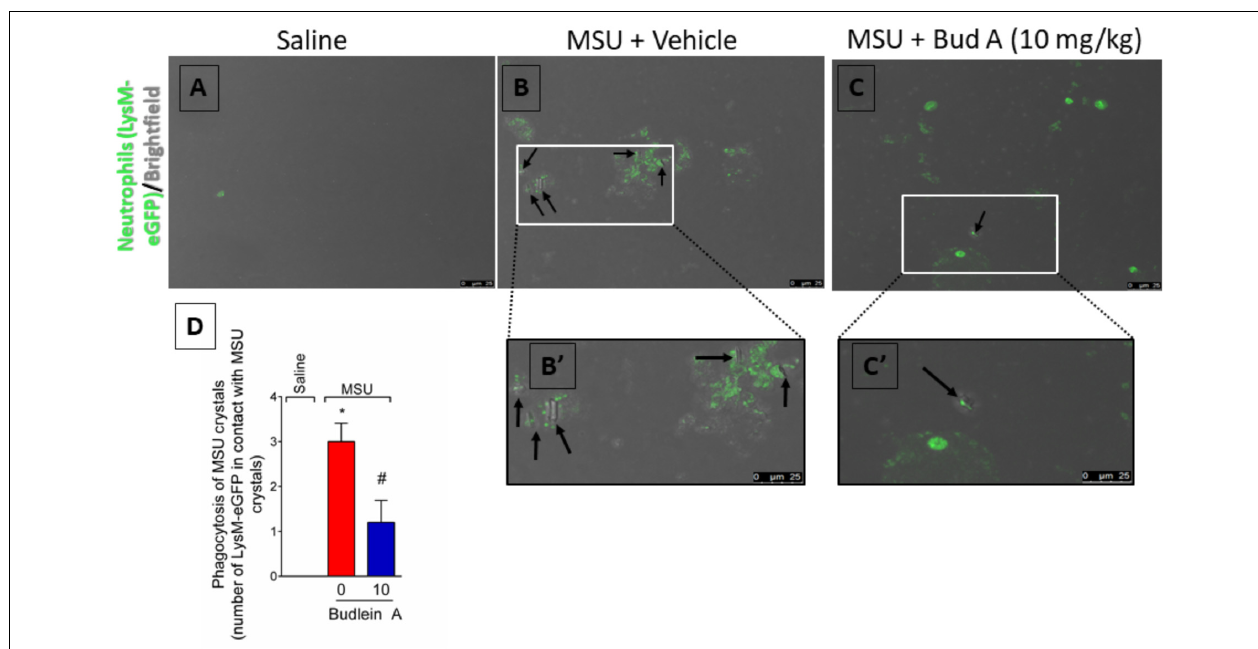
FIGURE 8 | Budlein A reduces phagocytosis of MSU crystals by neutrophils. Fifteen hours after the injection of MSU crystals, knee joint wash of LysM-eGFP mice was collected for quantification of phagocytosis of MSU crystals by neutrophils. Quantification was performed using the brightfield and the green channel using a confocal microscope [Original magnification 63 × , panels (A–C) ]. The representative number of LysM-eGFP positive cells in contact with MSU crystals counted in the 63 × objective is presented in panel (D) . ∗ p < 0.05 vs. saline group; # p < 0.05 vs. 0 mg/kg group, one-way ANOVA followed by Tukey’s post hoc .